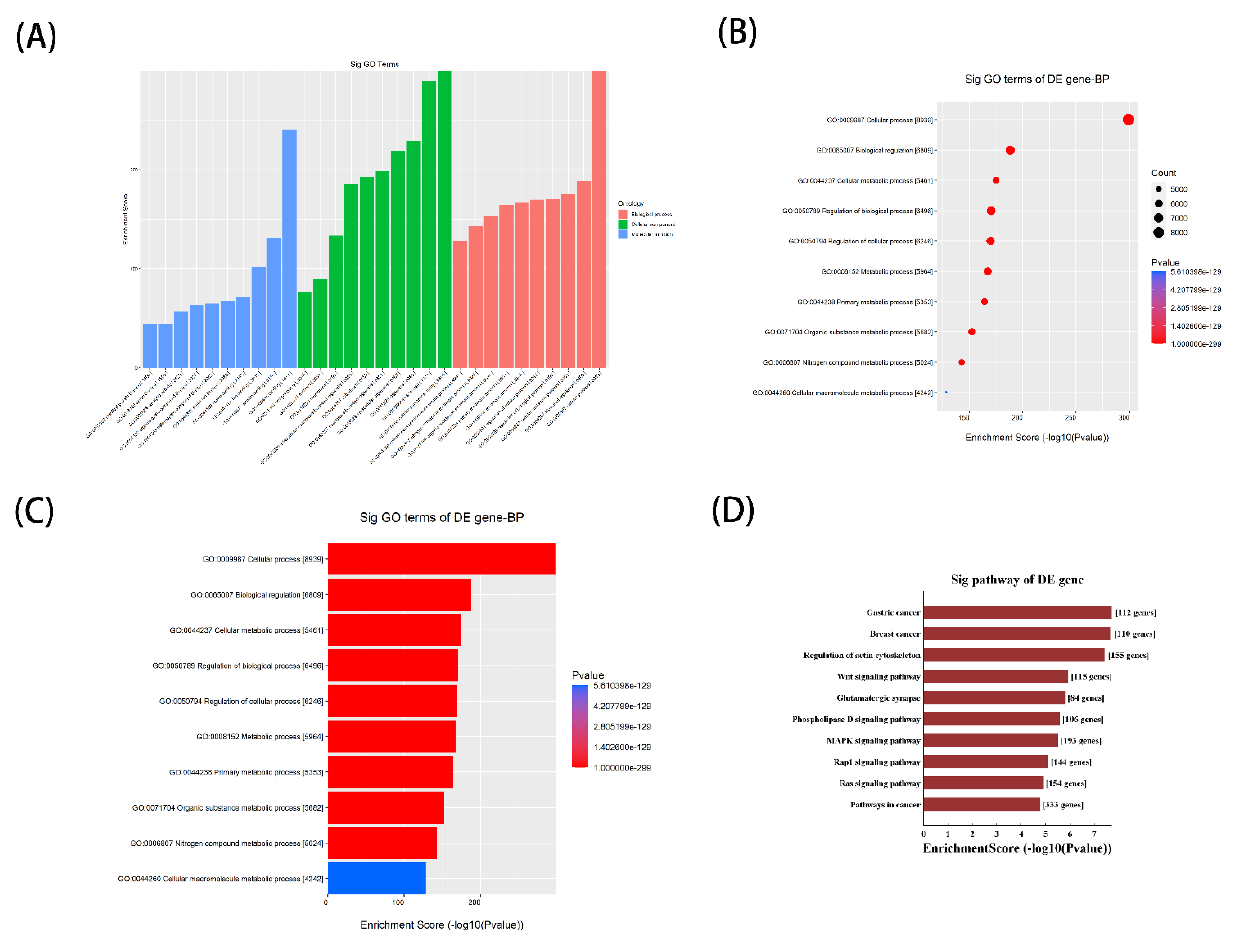
Figure 5. Potential function of septic cardiomyopathy-related tsRNAs revealed by GO and KEGG analysis. ( A )–( D ) Gene Ontology enrichment analysis and Kyoto Encyclopedia of Genes and Genomes pathway analysis for septic cardiomyopathy-related tsRNAs. BP: biological process; CC: cellular component; DE: differently expressed; GO: Gene Ontology; MF: molecular function; KEGG: Kyoto Encyclopedia of Genes and Genomes.